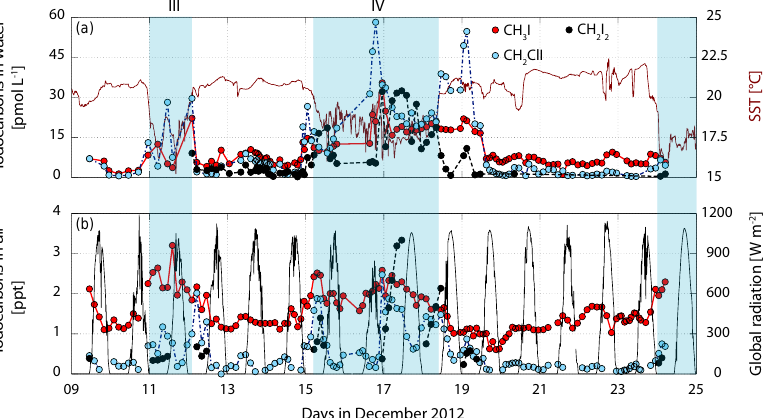
Figure 3. Surface water measurements of iodocarbons are presented in panel (a) with CH 3 I in red, CH 2 ClI in blue and CH 2 I 2 in black on the left side along with SST (dark red) on the right side. Additionally, atmospheric mixing ratios of CH 3 I (red), CH 2 ClI (blue) and CH 2 I 2 (grey) on the left side together with global radiation (black, taken from pyranometer measurements referring to total shortwave radiation) on the right side are depicted in panel (b) . Note that all times are in